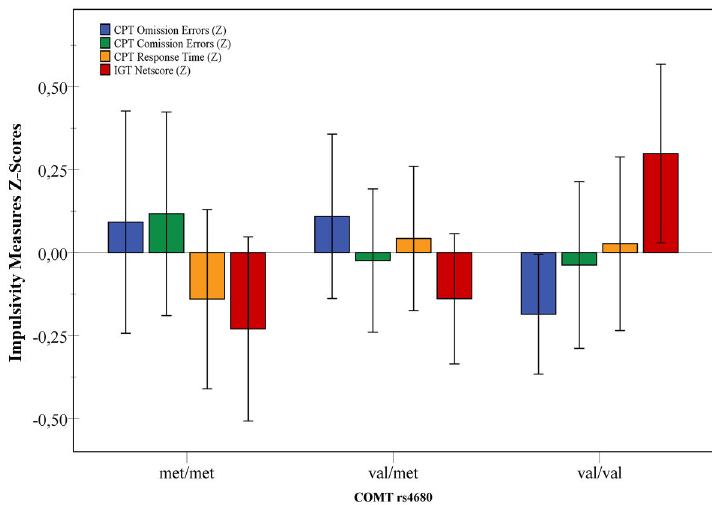
Figure 1. Mean Z-Scores for each Impulsivity measure along the COMT val158met groups. Significant differences were found on General Linear Models val homozygous when compared to val heterozygous (p=0.023) and met homozygous (p=0.019), with moderate effect sizes, suggesting a more impulsive response pattern by met carriers. No significant differences were found on CPT